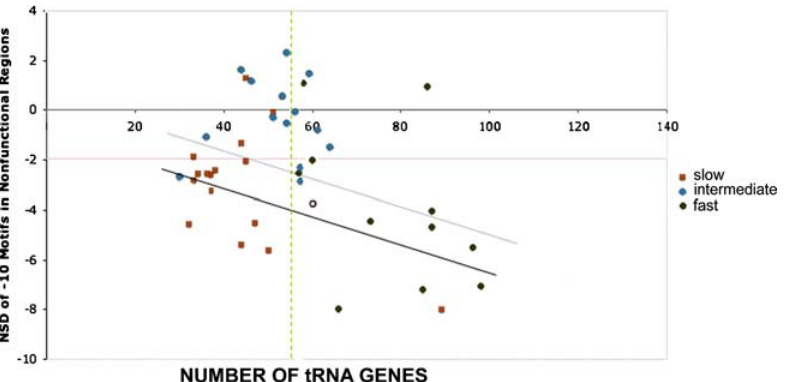
Figure 5. NSD of 2 10 motif counts in nonfunctional DNA correlate negatively with the number of tRNA genes in the genome. NSD values are defined as in the text and Figure 4. The red line represents 2 2 SD from the mean expected value of 2 10 motif counts in the nonfunctional DNA of the corresponding genome. The green line indicates the average number of tRNA genes in the genomes analyzed (55). The color-coding distinguishes species according to their maximal growth rate (see Table 1); no growth rate estimate was available for Corynebacterium glutamicum (not colored). Black dotted line: regression including all analyzed genomes (r=0.38 and p , 0.02). Black solid line: regression for the subset of genomes with NSD ,2 2 in nonfunctional DNA (r=0.63 and p ,